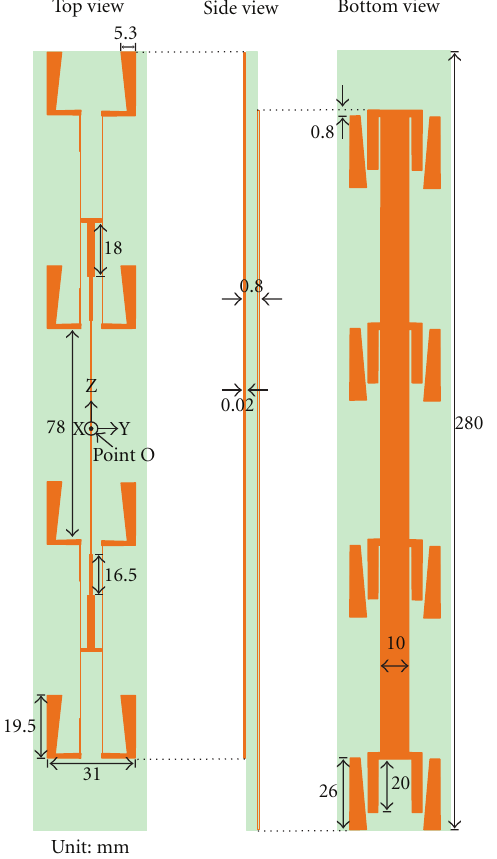
Figure 1: Geometry of the proposed planar dual-band dipole array with high-gain operation.